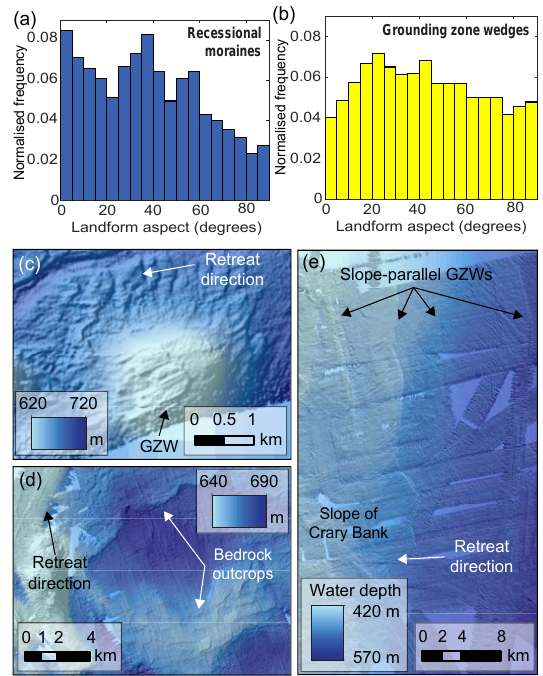
Figure 8. Landform aspect with respect to bed slope for (a) reces- sional moraines and (b) grounding zone wedges, in which 0 ◦ de- notes a landform whose long axis is oriented perpendicular to slope contours (“downslope”) and 90 ◦ denotes a landform oriented paral- lel to slope contours (“across slope”). Grounding zone wedges pref- erentially form on isolated bedrock highs (c, d) and bank slopes (e)